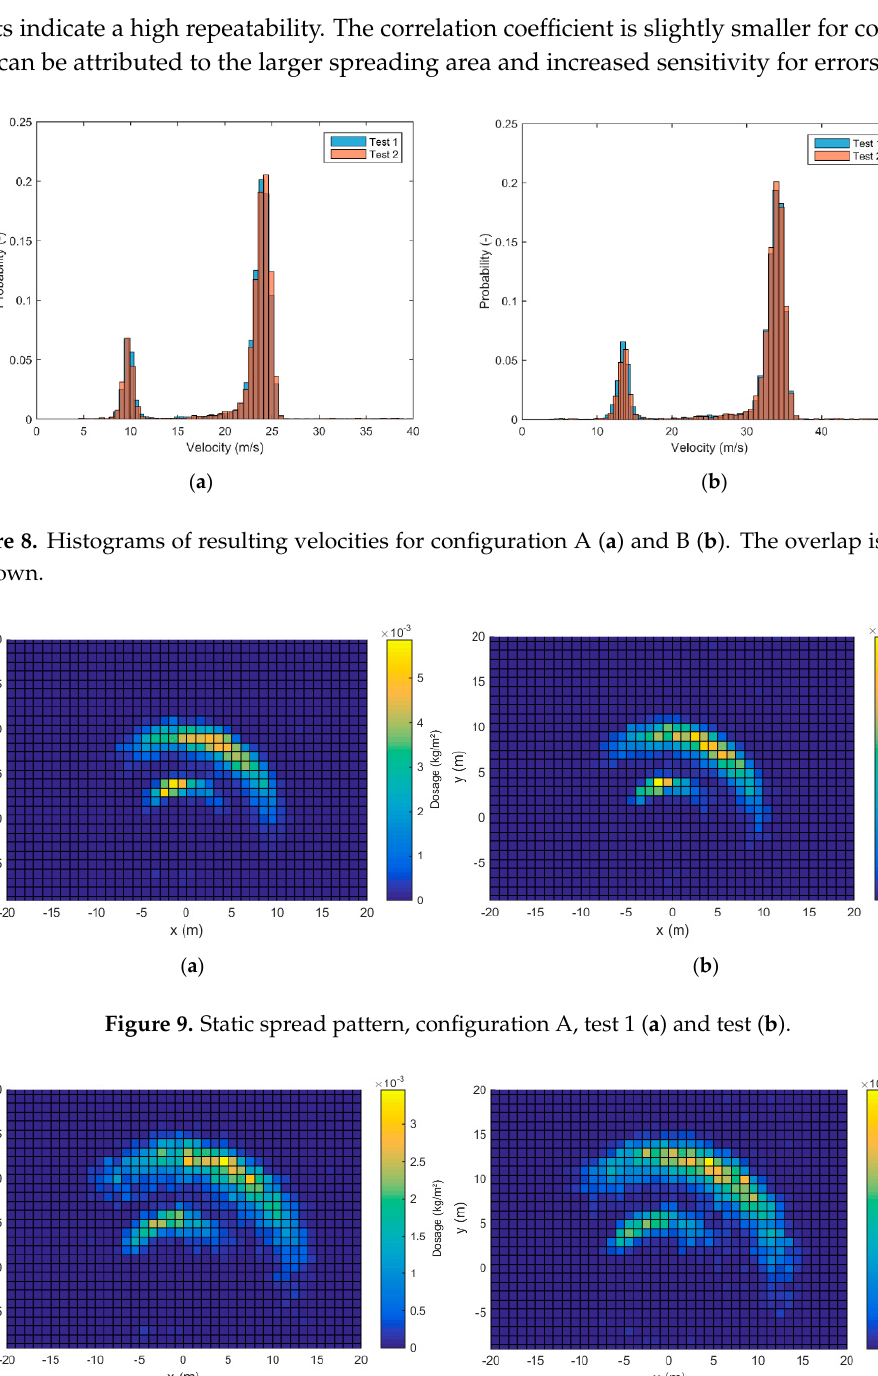
Figure 7. Particle 3D velocity components expressed in spreader coordinate system. The spreader was set at configuration B.